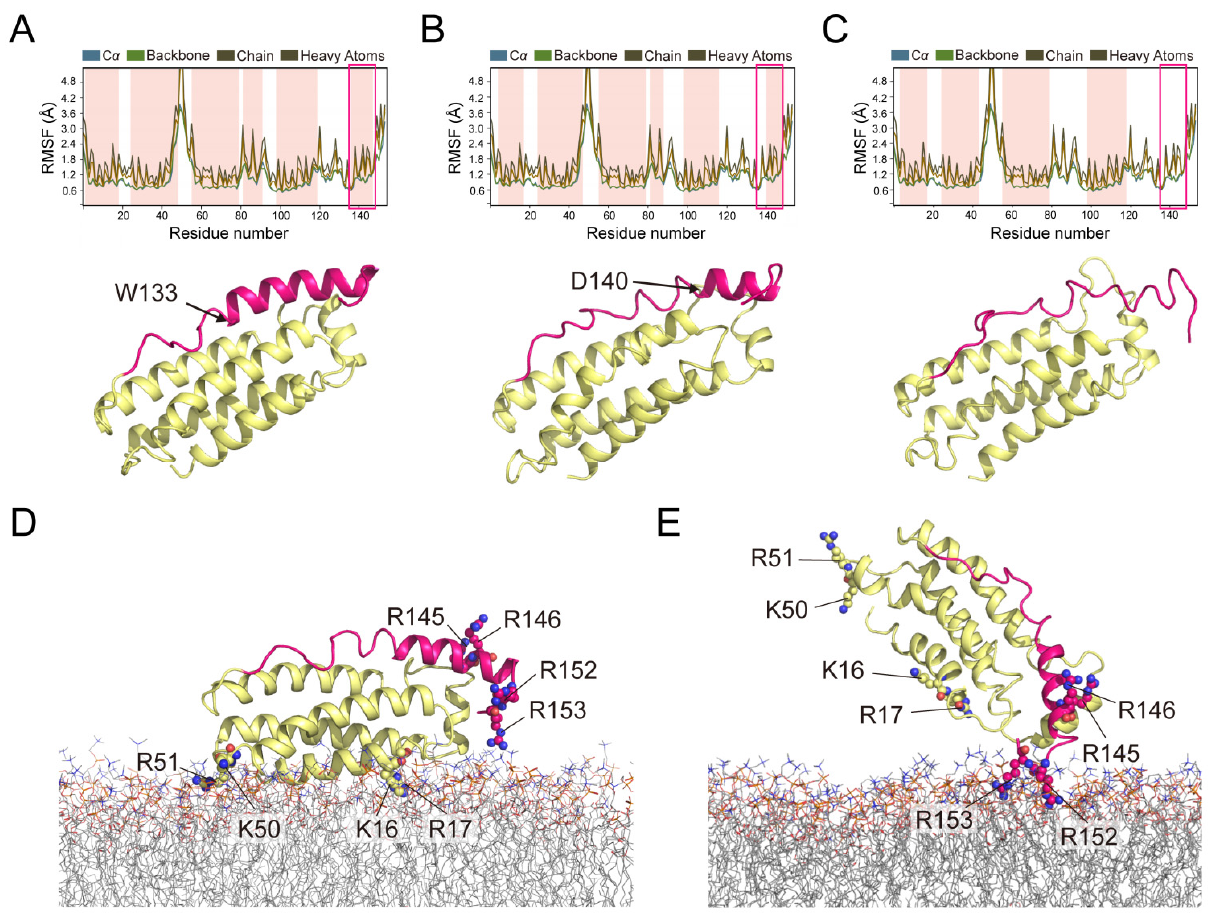
Figure 3. The MD simulations of MLKL 2–154 in pure water and in membranes. ( A ) The starting protein structure for 2MSV. The H6 helix (from residues 133 to 150) is present at that point in time and lasted for the first 7 nanoseconds. The RMSF is used for characterizing local changes along the protein chain, along with SSE (Secondary Structure Elements) of MLKL 2–154 highlighted in which α -helical regions are highlighted in pink. ( B ) The average structure over the 8th nanosecond, the residues 133–139 are no longer the SSE composition. ( C ) Over the entire simulation time (100 ns), H6 helix is missing, however, the helical structures of the NBD are still stable. ( D ) The initial position of MLKL 2–154 (PDB code: 2MSV) on the DMPC membrane predicted by the PPM Server. K16, R17, K50 and R51 are engaged initially opposite to the brace. ( E ) Over 100 ns simulation time, the positively charged cluster in the auto-inhibitory region got close to the membrane with R152 and R153 inserting into the membrane.